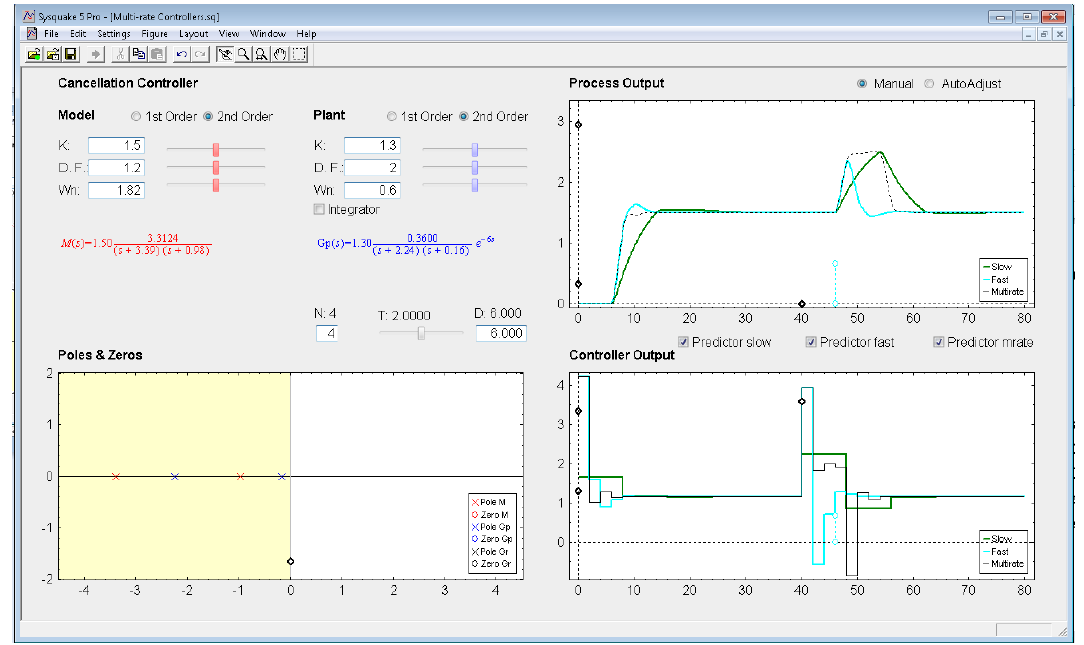
Figure 10. Application user interface for the Cancellation controller.